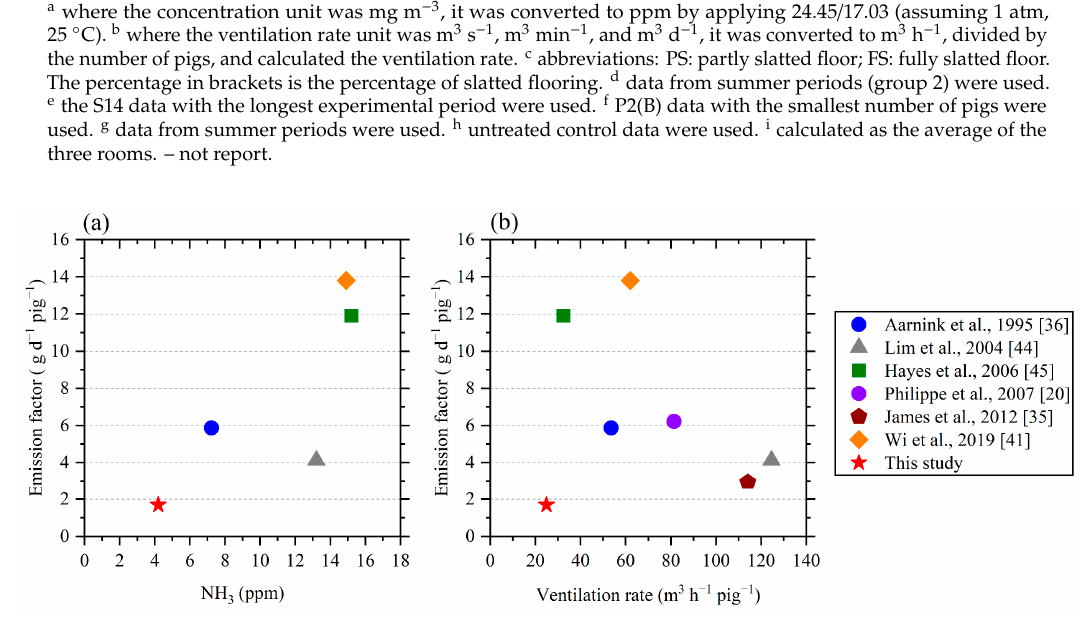
Table 6. Comparison of pig farm characteristics and results of this study with that of other published studies. Growing length, number, and weight range of pigs, and ammonia concentration, temperature, ventilation rate, ammonia emission factor, and flooring type of finishing swine farms using a mechanical ventilation system are compared.